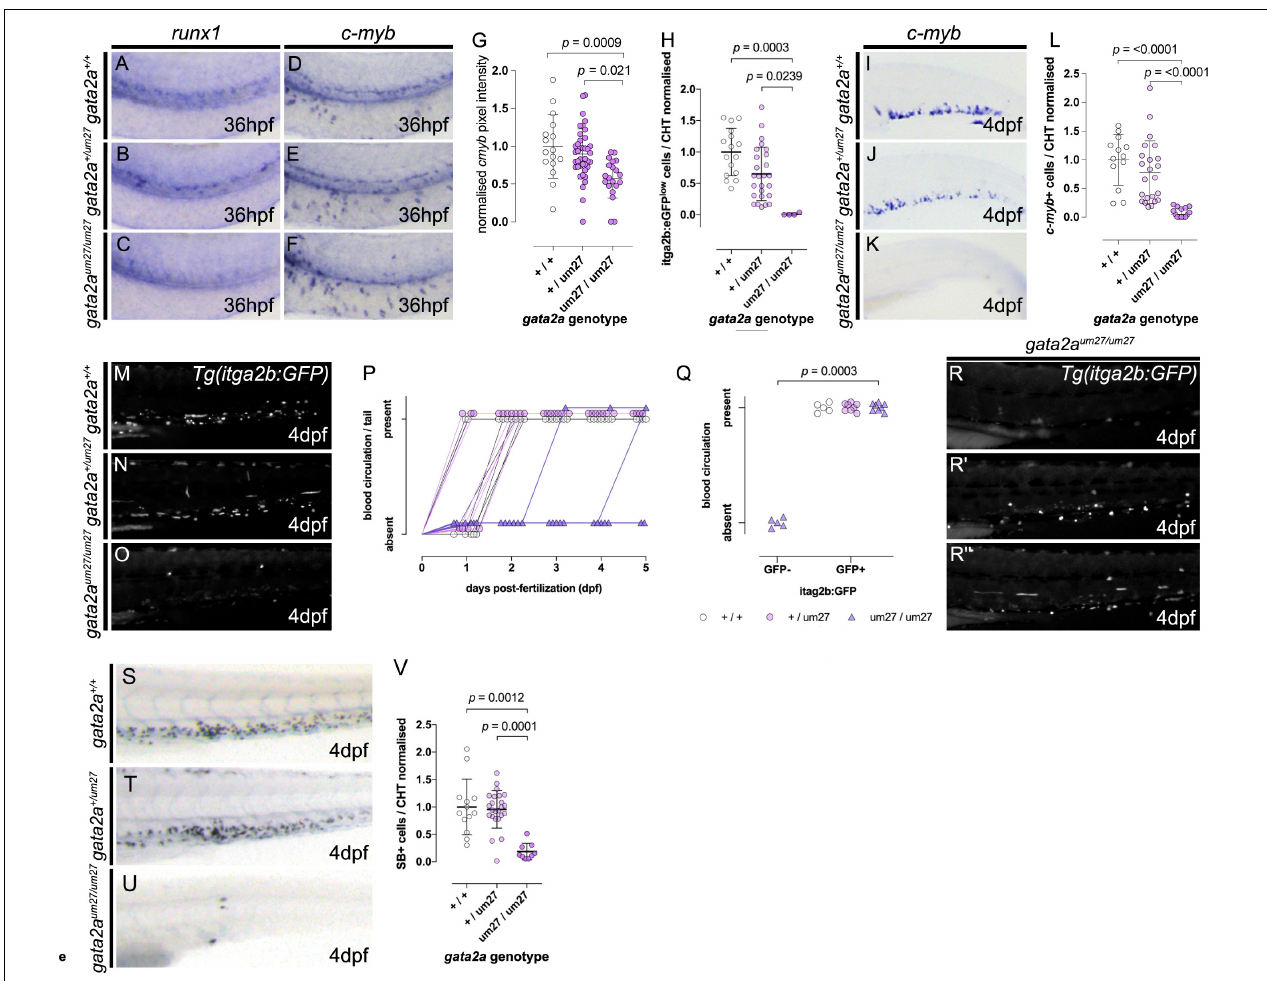
FIGURE 2 | Impaired HSPC development in gata2a mutants. (A–C) Expression of runx1 by in situ hybridization in 36 hpf embryos, showing decreased expression in gata2a um 27 / um 27 homozygotes. (D–F) Lateral views of c-myb WISH on 36 hpf Gata2a um 27 mutants showing decreased expression in in gata2a um 27 / um 27 homozygotes. (G) Quantification of c-myb expression from in situ hybridization images in the AGM of 36 hpf embryos. In (H) mutant fish carrying itga2b:GFP transgene, labeling HSPCs that reside in the CHT, were used to quantify GFP low cells in the CHT of 56 hpf embryos, showing an allele dependent decrease in GFP low cells. (I–K) Lateral views of 4 dpf larvae showing the expression of c-myb by in situ hybridization. (L) Quantification of c-myb + cells in the CHT of 4 dpf mutant larvae. (M–O) Lateral views of the tails of 4 dpf mutant Tg(itga2b:GFP) fish showing a decrease of GFP+ cells in gata2a um 27 / um 27 homozygotes. In (P) , the presence (up) or absence (bottom) of blood flow in the tail of Gata2a um 27 mutant fish was monitored each day until 5 dpf. Notice the gata2a um 27 / um 27 homozygotes (purple triangles) gaining blood circulation at 3 and 5 dpf. (Q) Plot showing the correlation of the presence (up) or absence (bottom) of blood flow in the tail of Gata2a um 27 mutant fish and the presence (right) or absence (left) of Tg(itga2b:GFP) + cells in 4 dpf fish. At 4 dpf, some gata2a um 27 / um 27 homozygotes (purple triangles) show GFP+ cells, all of which also exhibit circulation in the tail. (R–R (cid:48)(cid:48) ) Lateral views of 4 dpf mutant Tg(itga2b:GFP) fish showing a range of phenotypes of gata2a um 27 / um 27 homozygotes. (S–U) Lateral views of 4 dpf mutant larvae stained with SB. (V) Quantification of SB+ cells in the CHT of 4 dpf larvae shows decreased number of granulocytes in gata2a um 27 / um 27